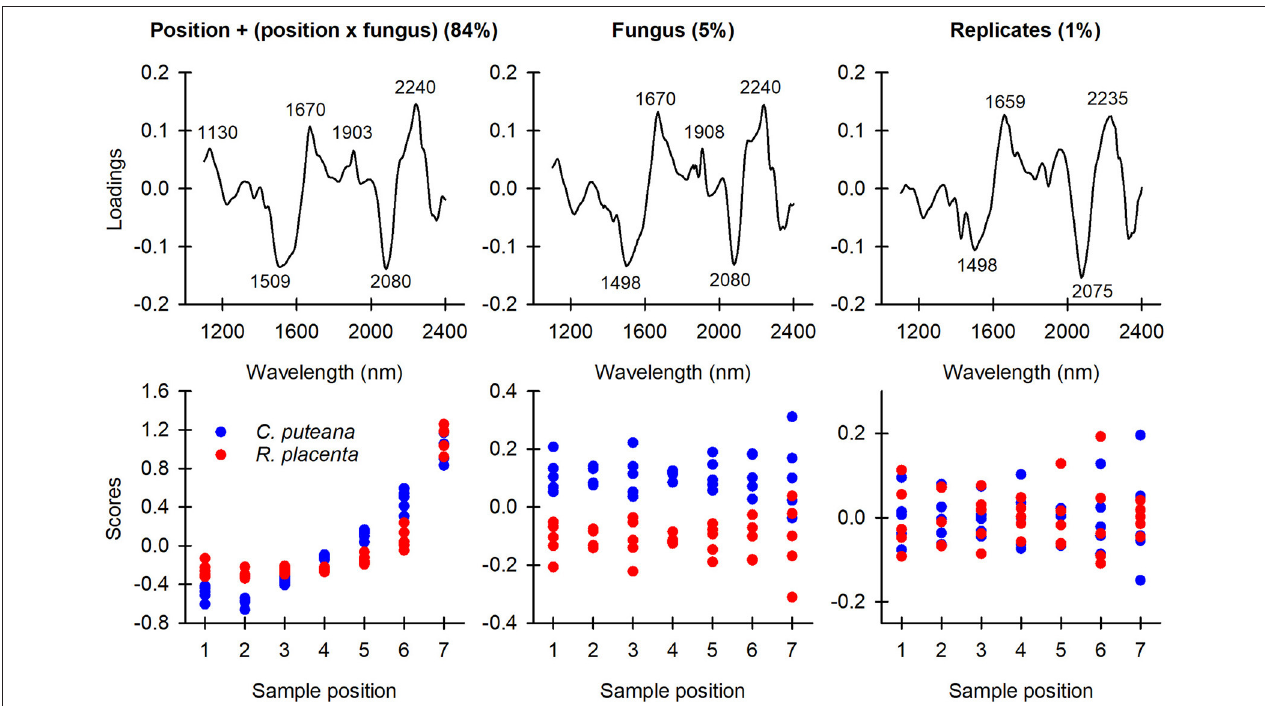
FIGURE 3 | ASCA first component loadings and scores of the position + (position × fungus) combination effect, the fungus effect, and the replicate